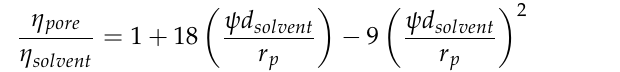
Figure 2. Schematic representation of a solvent drop on membrane surface with different degree of hydrophobicity. ( a ) Hydrophilic membrane and polar solvent or Hydrophobic membrane and apolar solvent; ( b ) Semi-Hydrophilic membrane and polar solvent and ( c ) Hydrophilic membrane and apolar solvent or Hydrophobic membrane and polar solvent.